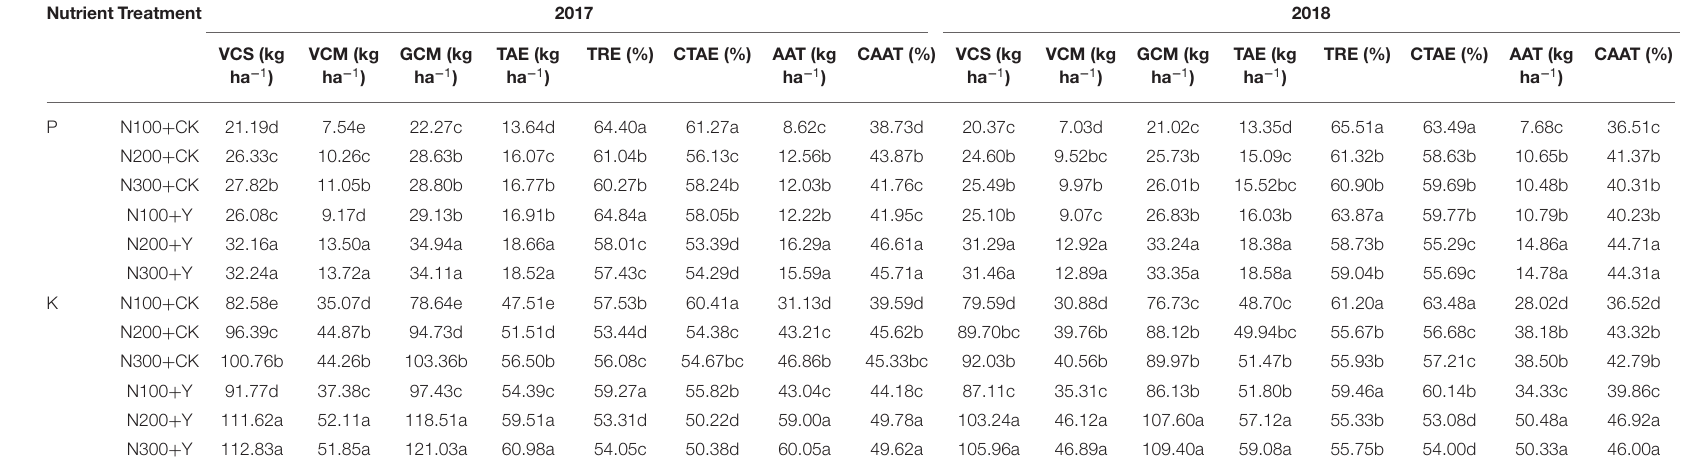
TABLE 6 | Effects of chemical control and nitrogen fertilizers on maize nutrient (P and K) translocation and contribution during the maize growing period 2017 and 2018. Nutrient